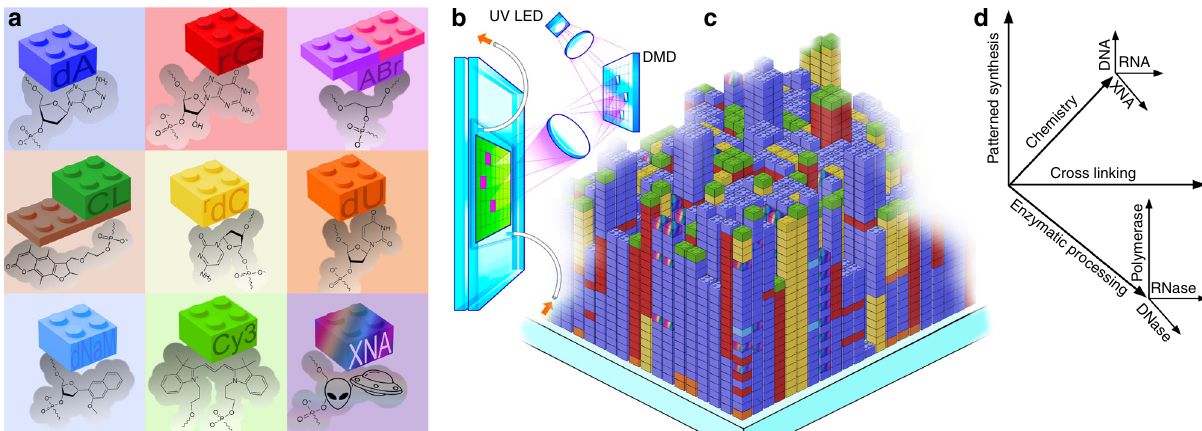
Fig. 1 Building blocks, photolithographic synthesis and orthogonal processing for multi-patterning nucleic acid photolithography. a High-level schematic depiction and molecular detail of representative elements of classes of nucleic acid building blocks available for photolithographic synthesis. These elements include essentially all biogenic nucleic acids (canonical and non-canonical DNA and RNA nucleotides), structural modi fi ers including branching and spacing monomers, fl uorescent and functionalizing modi fi ers, and engineered xenobiotic nucleic acid (XNA) monomers with modi fi ed sugars, bases or backbones. b Massively parallel surface synthesis is performed using maskless photolithography mediated by patterned light from a digital micromirror device to selectively remove the photolabile protecting group present on each monomer. c Surface synthesis results in dense arrays including hundreds of thousands to millions of unique sequences at de fi ned positions. d Multi-level patterning includes multiple orthogonal surface modi fi cations: patterned surface biopolymers synthesis with free choice of monomer chemistry, further modi fi cation with additional photochemistry, and fi nal modi fi cations with a variety of nucleic acid processing enzymes ranging from DNA and RNA polymerases to nucleases such as uracil-DNA glycosylase and RNase